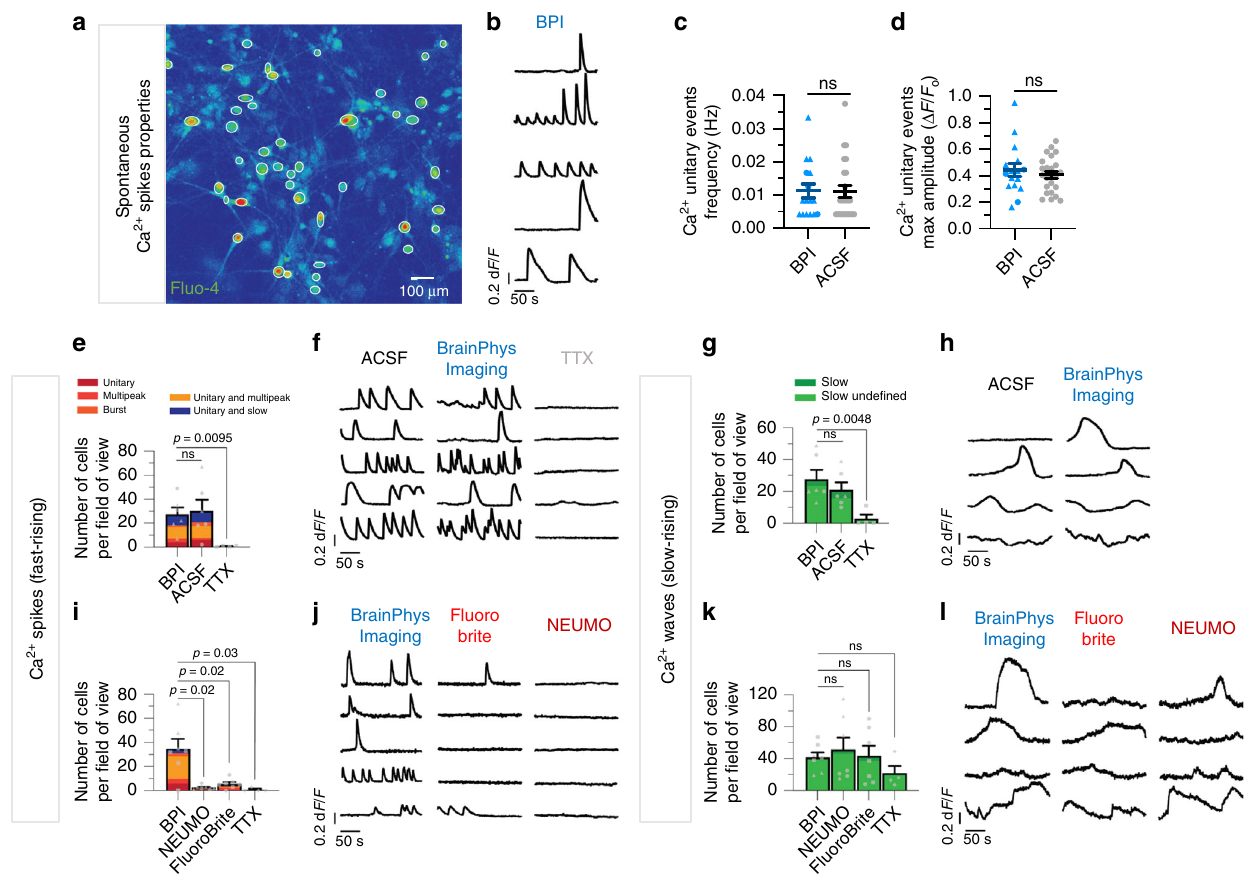
Fig. 6 BrainPhys Imaging optimally supports fast-rising calcium spikes in human neurons in vitro. Intracellular Ca 2 + changes in human PSC-derived neurons were measured with time-lapse image sequences of a Ca 2 + sensor (Fluo-4 AM). A total 1225 human neurons were analyzed across thirteen fi elds of view (FOVs) from four coverslips ( n = 4 biologically independent experiments). Regions of interest (ROIs) were drawn on the cell soma to determine fl uorescence intensity changes ( Δ F / F Δ F / F 2 + spikes or 0 ) over time. Active events ( 0 > 5% from baseline) were manually categorized into fast-rising Ca slow-rising Ca 2 + waves (see Fig. S8A). The same FOVs were imaged in arti fi cial cerebrospinal fl uid (ACSF), BPI, FluoroBrite, and NEUMO. a Example Fluo- 4 AM fl uorescence image of a neuronal population in BPI. White circles represent active ROIs. Fluorescent intensity represents intracellular Ca 2 + levels. b Typical fast-rising Ca 2 + spikes from fi ve active cells in BPI. c , d No signi fi cant difference was observed between the average properties of fast-rising unitary Ca 2 + spike events in BPI ( n = 16 cells) and ACSF ( n = 24 cells) from six FOVs across two coverslips. e , g No signi fi cant difference was observed between the proportions of cells with fast Ca 2 + spikes or slow Ca 2 + waves in BPI and ACSF. The total active cells (BPI: n = 329; ACSF n = 308) were compared across six FOVs from two coverslips. Voltage-gated sodium channel blocker Tetrodotoxin (TTX, 1 µ M) signi fi cantly reduced Ca 2 + spikes and waves. See also Supplementary Fig. 8a. i , k Comparison of Ca 2 + signals in BPI, NEUMO, and FluoroBrite show signi fi cant differences in the proportions of cells with Ca 2 + spikes but not waves. Active cells with Ca 2 + spikes and spikes/waves in BPI ( n = 243 cells), FluoroBrite ( n = 39 cells) and NEUMO ( n = 18 cells) or with Ca 2 + waves in BPI ( n = 288 cells), FluoroBrite ( n = 302 cells), and NEUMO ( n = 356 cells) were compared across seven FOVs from two coverslips. f , h , j , l Example traces from the same ROIs in different media. Symbols in c – e , g , i , k represent cells recorded fi rst (triangles), second (circles), third (square), fourth (diamond) in either medium. Values are presented as mean ± SEM. Signi fi cance in c – e , g , i , k determined via two-tailed nonparametric unpaired (Mann – Whitney) tests. ns, P >